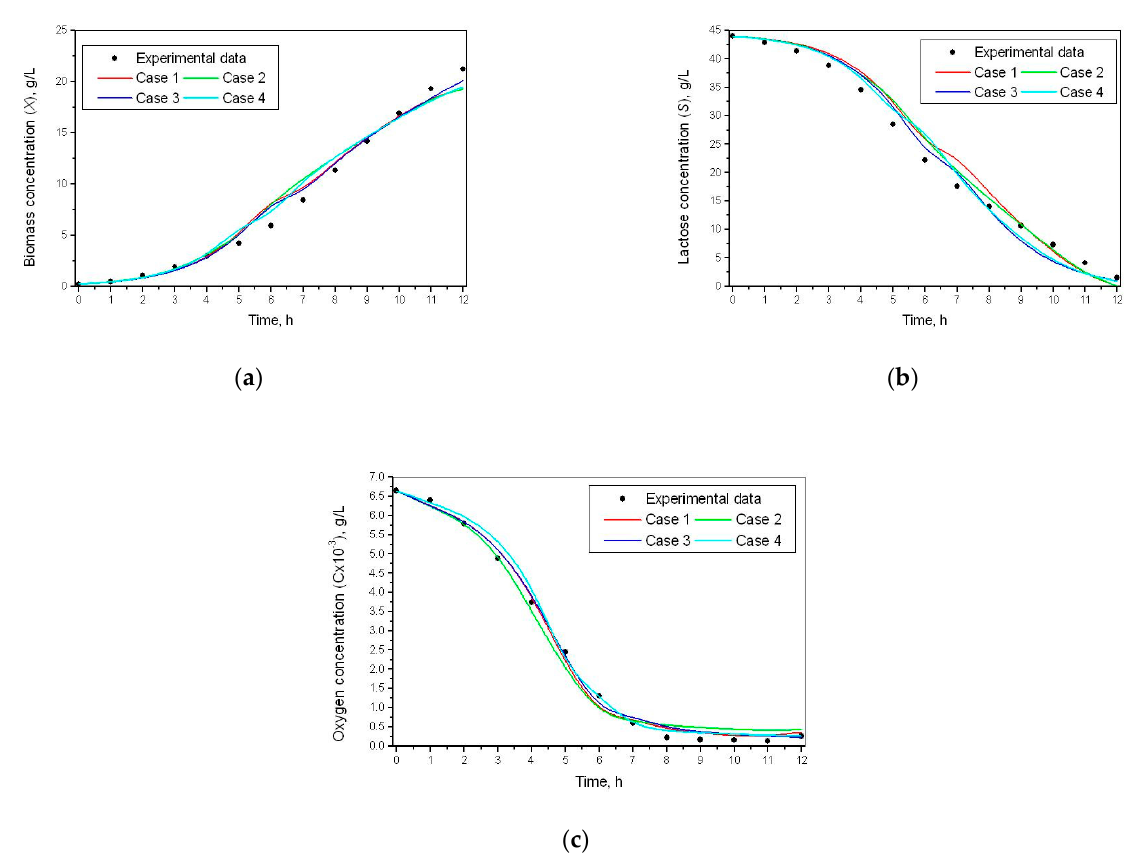
Figure 3. Simulation results for kinetics variables of the process. ( a ) Biomass concentration; ( b ) lactose concentration; ( c ) oxygen concentration.